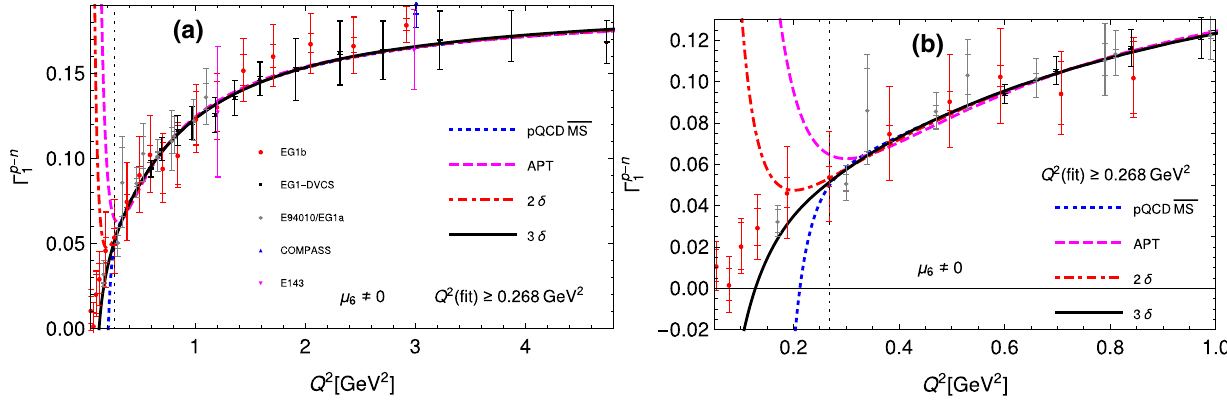
= 0 . 268 GeV 2 : a for larger Q 2 ; b for Q 2 < 1 GeV 2 . The lower bound of the fitting interval, Q 2 Fig. 3 As Fig. 2, but for Q 2 min is included as the thin dotted vertical